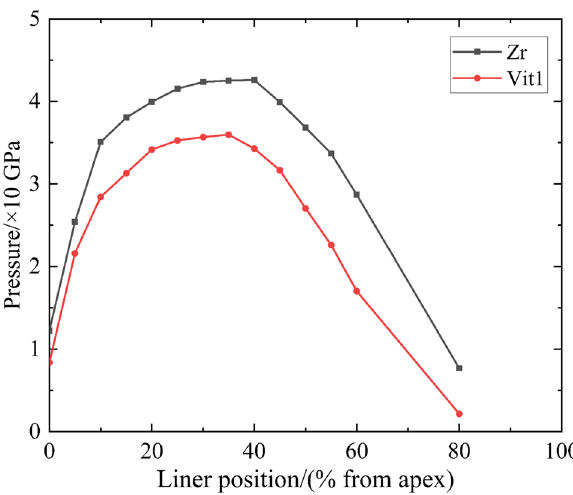
Figure 19. Stagnation pressure